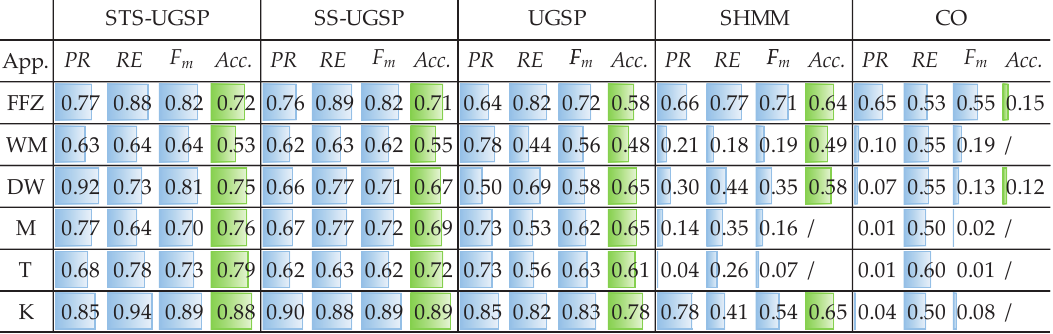
Figure 6. NILM Performance comparison for REFIT House